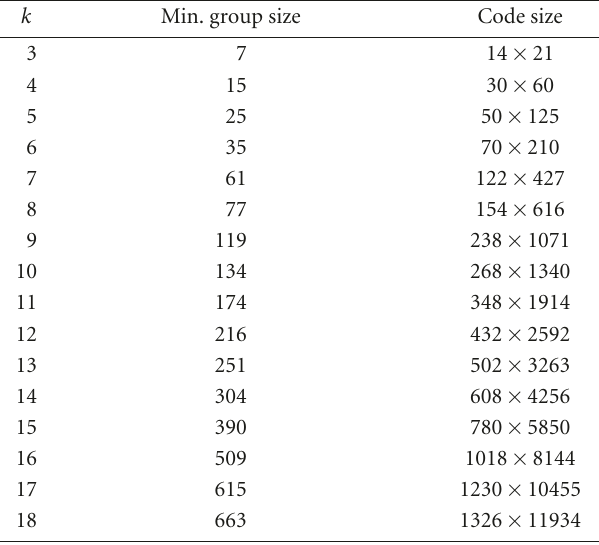
Table 1: Smallest girth-twelve code sizes obtained with two groups and a sequential